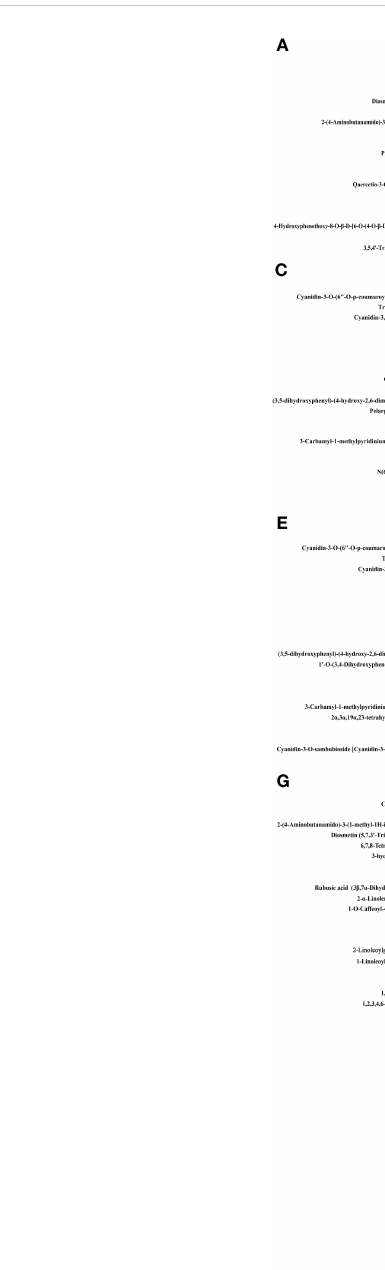
FIGURE 12 Variance multiplier bar chart, the horizontal coordinate is the value of the difference multiplier of the difference metabolite taken as logarithm with a base of 2. The vertical coordinate is the difference metabolite. Red represents up-regulation of metabolite content, blue represents down-regulation of metabolite content. Y-R vs Q-R, Y-RP vs Q-RP, Y-RS vs Q-RS, Q-R vs Q-RP, Q-R vs Q-RS, Q-RP vs Q-RS, Y-R vs Y-RP, Y-R vs Y-RS, and Y-RP vs Y-RS (A – I)